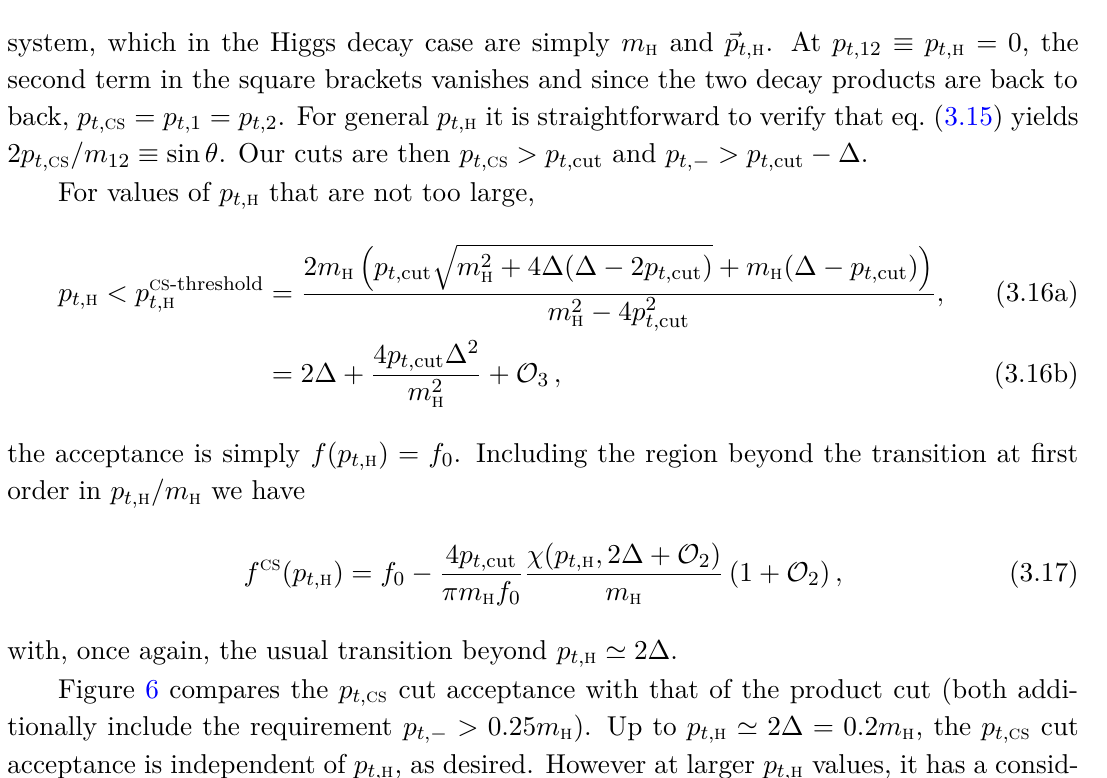
Figure 6 . Comparison of the p t, h -dependent acceptance of the Collins-Soper p t, cs cut with that of the product cuts (both sets of cuts also include the constraint p t, − > 0 . 25 m h ), as well as a cut just on the softer photon p t (i.e. a symmetric cut). As in figures 2 and 4, the points corresponds to Monte Carlo evaluations of the acceptances. Note the different scale used